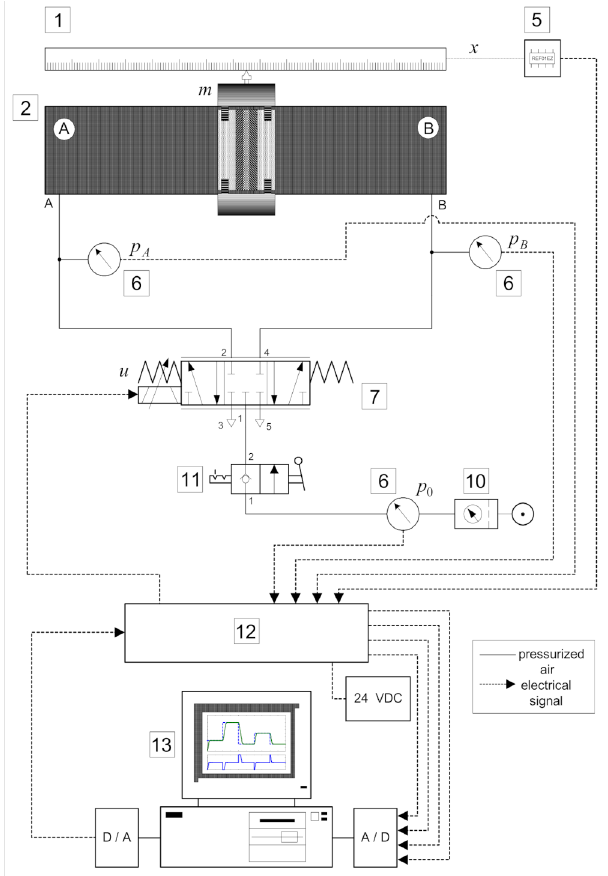
Figure 2. Schematic diagram of the control